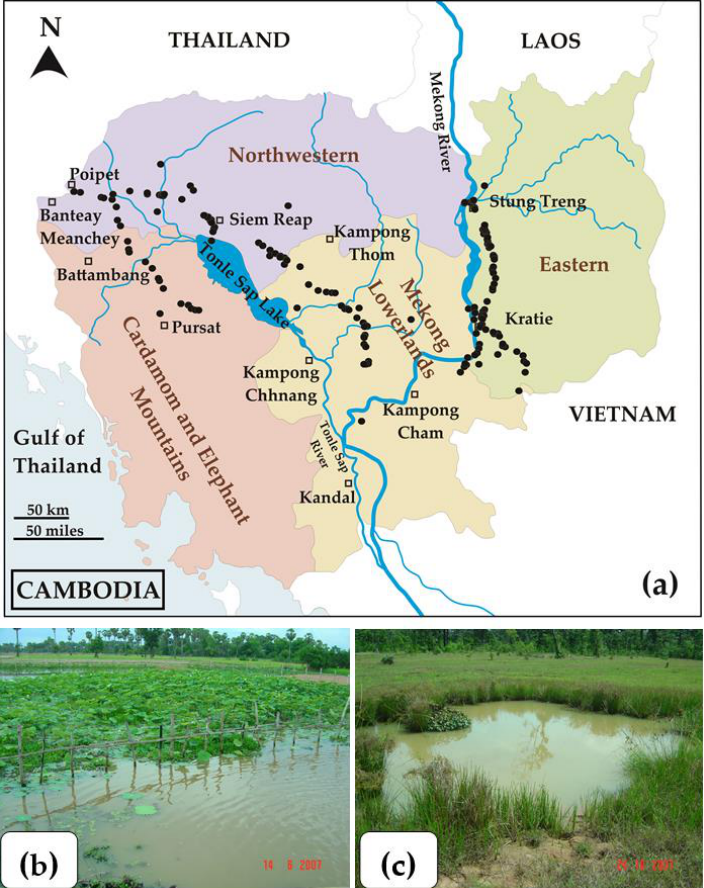
Figure 1. Sampling sites in Cambodia: ( a ) a map with 237 sites (black dots) and cities (open black squares) from four geographical regions: the northwestern region, the Cardamom and Elephant Mountains, the Mekong Lowlands, and the eastern region; ( b ) a permanent pond with lotus plants in Kampong Thom Province; and ( c ) a temporary pond in Kratie Province.